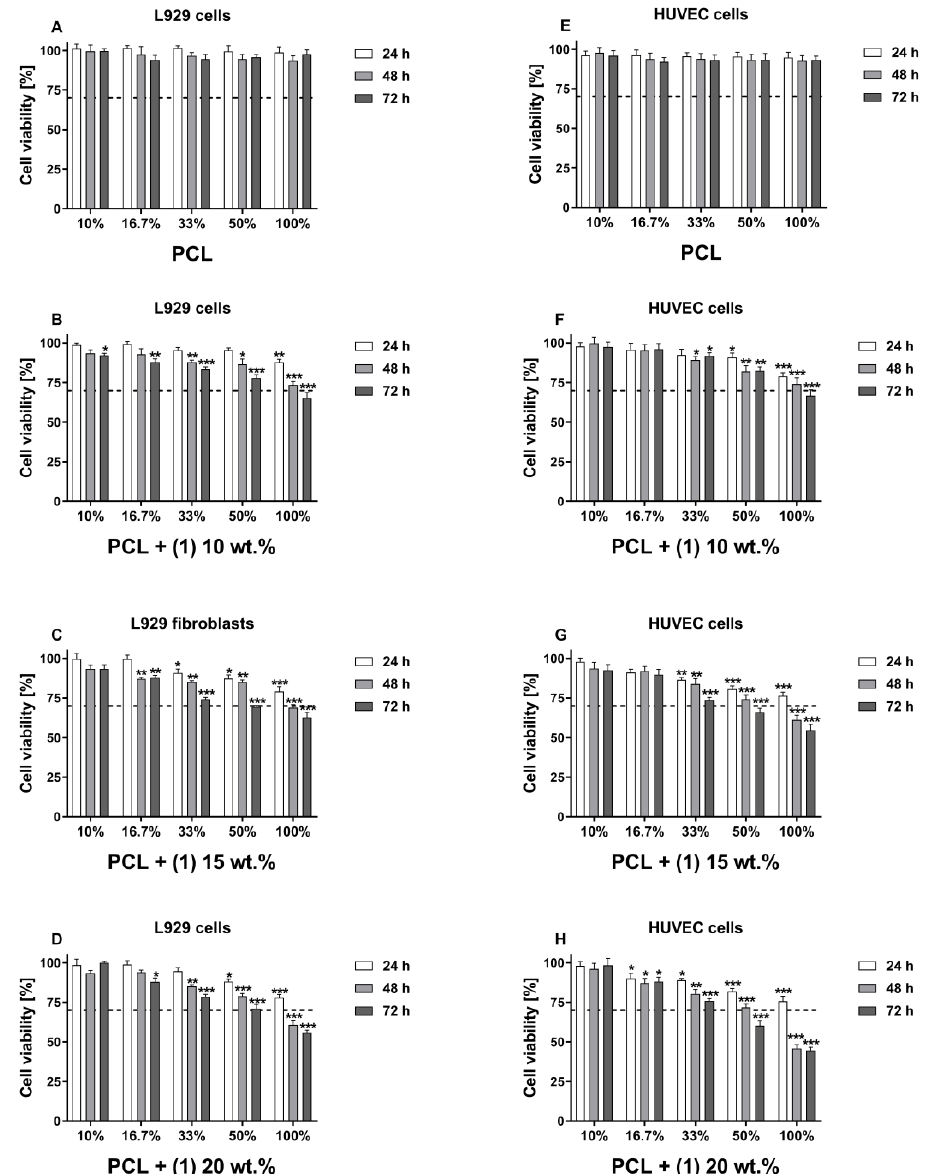
Figure 1. Cytotoxicity of the extracts from PCL and PCL + ( 1 ) samples containing the different concentrations of TOC that were estimated for L929 fibroblasts ( A – D ) and human umbilical vein endothelial (HUVEC) cells ( E – H ). Cells were incubated in the different concentrations of extracts (10%, 16.7%, 33%, 50% and 100%) for 24, 48 and 72 h. Cell viability (estimated using MTT assay) was presented as percentage ± SEM. of the control cells cultivated in corresponding concentrations of culture control media that were treated in the same way as extracts. Asterisks show significant differences between the cells cultured in control media (served as 100%) and the cells incubated with the extracts (*** p < 0.001; ** p < 0.01; * p < 0.05). Dash lines present potential cytotoxicity of the extraction media when the cell viability decreases below 70% according to ISO norms.